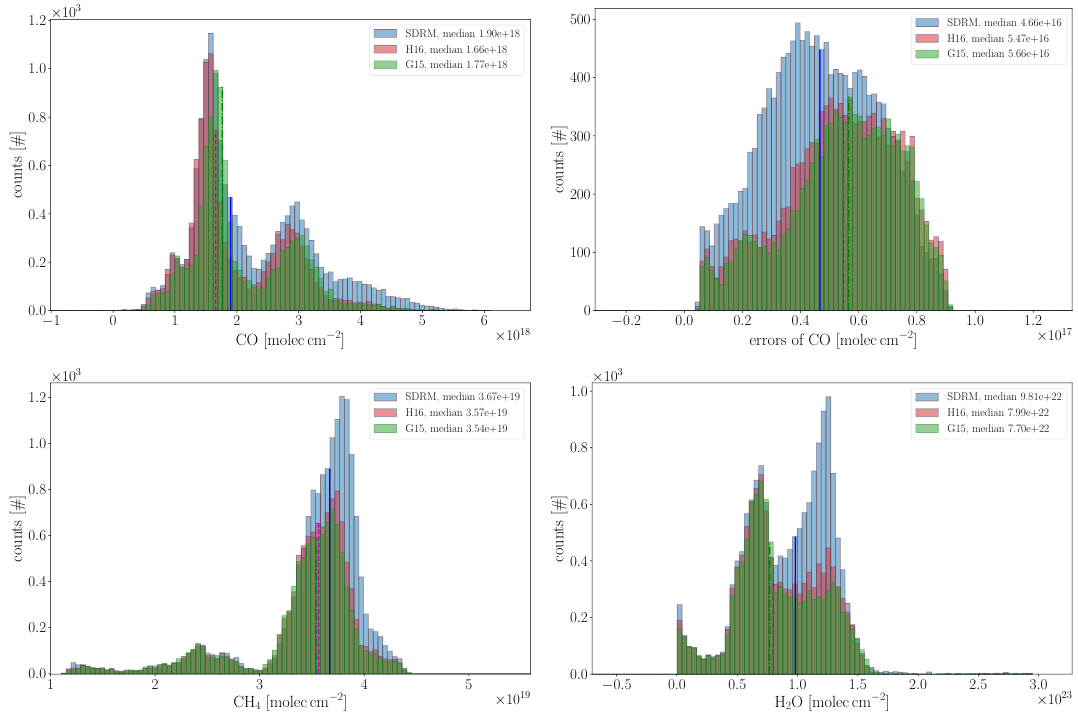
Figure 13. Distribution for the Amazonia region which include an overpass during the heavy forest fires in summer 2019 (orbit 9553 on 17 August 2019).